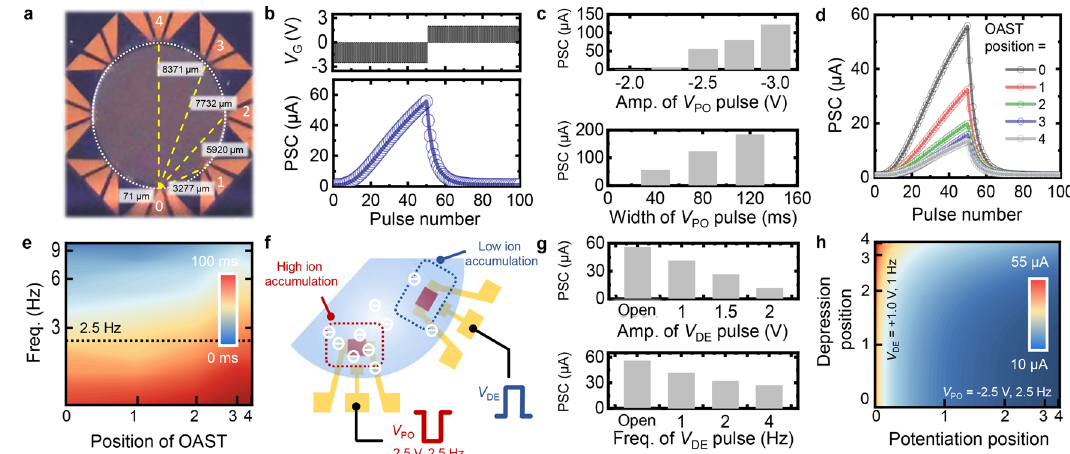
Fig. 2 | Characterization of the PPSA. a A photograph of the PPSA, with its dimensionsshown. b PSCchange ofanOASTunder consecutive 50 V PO pulsesand 50 V DE pulses( V PO =2.5V,40msand V DE =2V,40ms). c PSCchangeforvarious V PO conditions (amplitude of V PO : − 2.0 to − 3.0V; width of V PO : 40 – 120ms). d PSC change with increasing distance between the applied gate and an